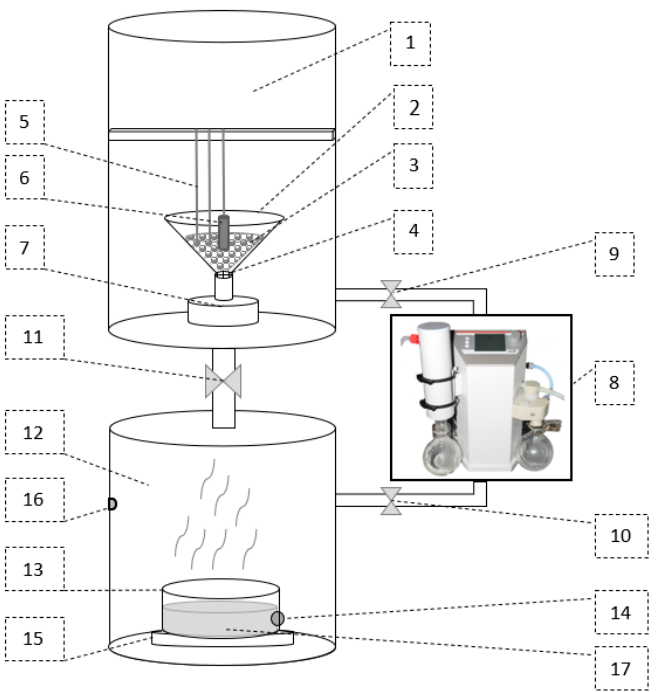
Figure 3. The scheme of the intensified heat transfer adsorption bed reactor: 1—reaction chamber, 2—conical spouted bed, 3—research material, 4—grid, 5—thermocouple, 6—heating probe, 7— weight measurement, 8—vacuum pump, 9—11 valves, 12—evaporator, 13—water tank with a heater, 14—temperature sensor, 15—weight measurement, 16—pressure sensor, 17—heater.